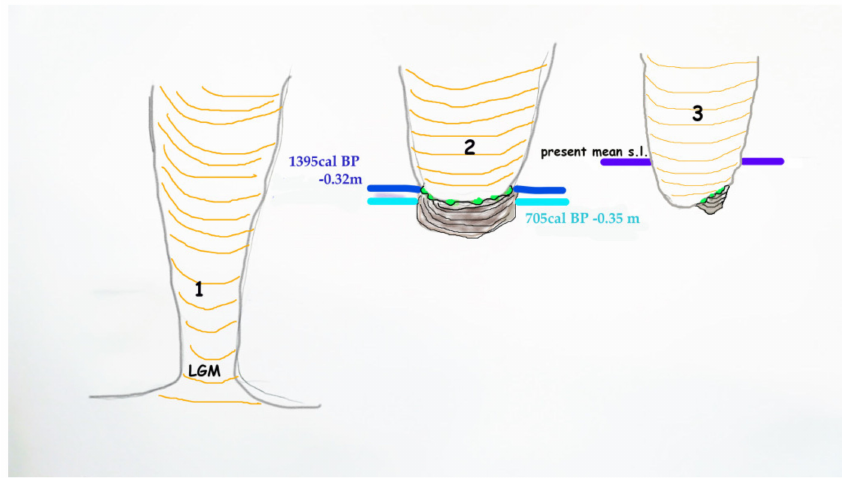
Figure 11. Evolution of the speleothem sampled in the stalactite cave on Favignana. (1) Continental deposition during the last glacial maximum. (2) The sea level was 0.35 m lower during serpulid overgrowth. (3) Present-day conditions.